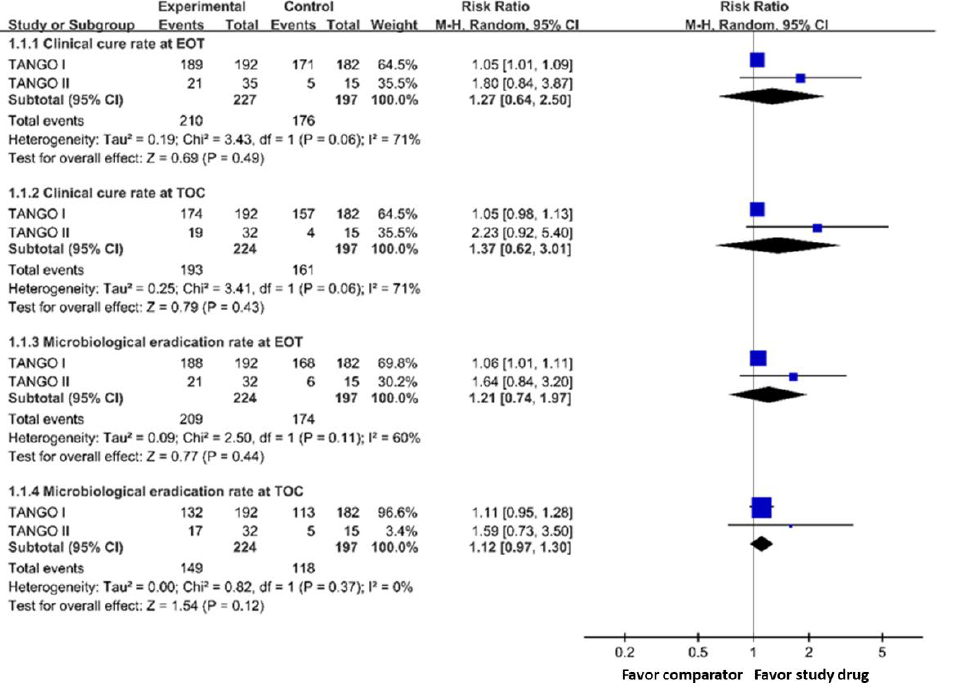
Figure 1. Clinical cure rate and microbiological eradication rate of meropenem-vaborbactam and comparator in microbiological modified intention-to-treat population analysis. Legend: EOT, end of treatment; TOC, test of cure.